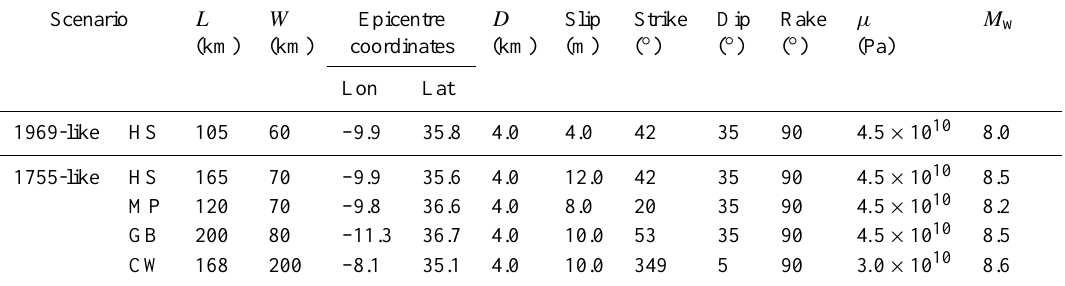
Table 1. Fault parameters of considered tsunamigenic scenarios compatible with both 1969 and 1755 events. Scenarios: HS (Horseshoe), MP (Marques de Pombal), GB (Gorring Bank), CW (Cadiz Wedge); L : the fault length in km; W : the fault width in km; D : the depth from the sea bottom to the top of the fault in km; µ : the shear modulus; and M w : the moment magnitude. Scenario L W Epicentre D Slip Strike Dip Rake µ M w (km) (km) coordinates (km) (m) ( ◦ ) ( ◦ ) ( ◦ ) (Pa) Lon Lat 1969-like HS 105 60 –9.9 1755-like HS 165 MP 120